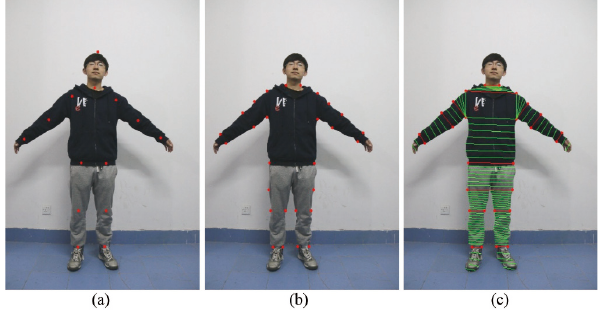
Fig. 5 Joints and control points: (a) joints obtained using CPM, (b) control point pairs P , and (c) control point pairs Q .